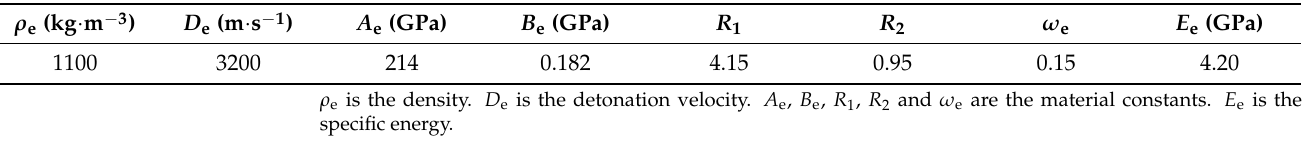
Table 2. Main constitutive parameters of